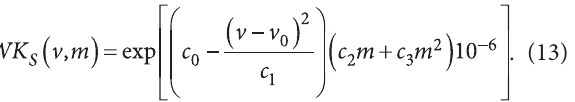
Table 4. Parameters of speed-dependent fuel consumption indexes ( WZ ) for different vehicle groups Vehicle group